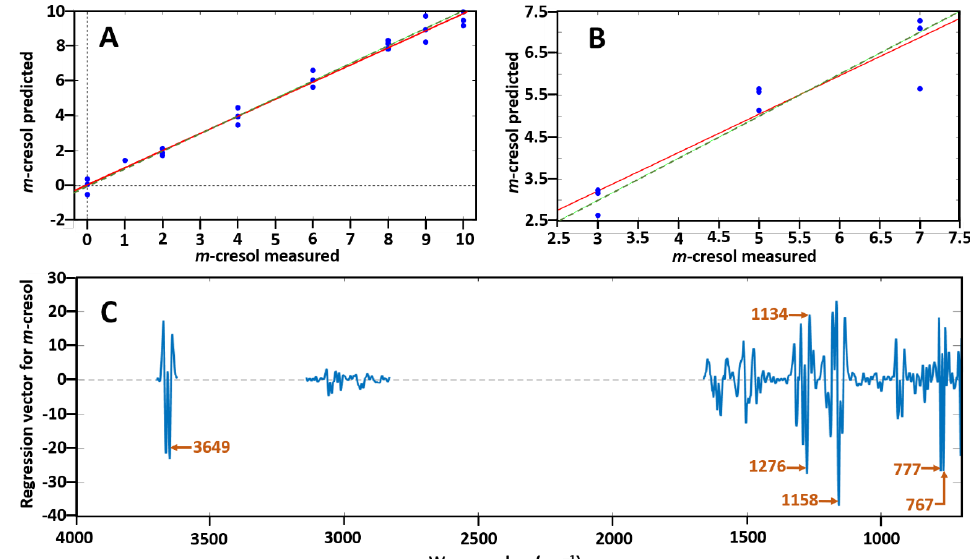
Figure 4. ( A ) Predicted m -cresol concentration ratio vs. measured m -cresol concentration ratio with the use of the partial least squares (PLS) regression model; ( B ) prediction set of m -cresol; and ( C ) loadings plot corresponding to the PLS model with labelling of the most significant bands which allow prediction of m -cresol from p -cresol. In both (A) and (B) the green dotted line represents the expected 1:1 proportional fit whilst the red continuous line shows the fit calculated by the model on the test data.